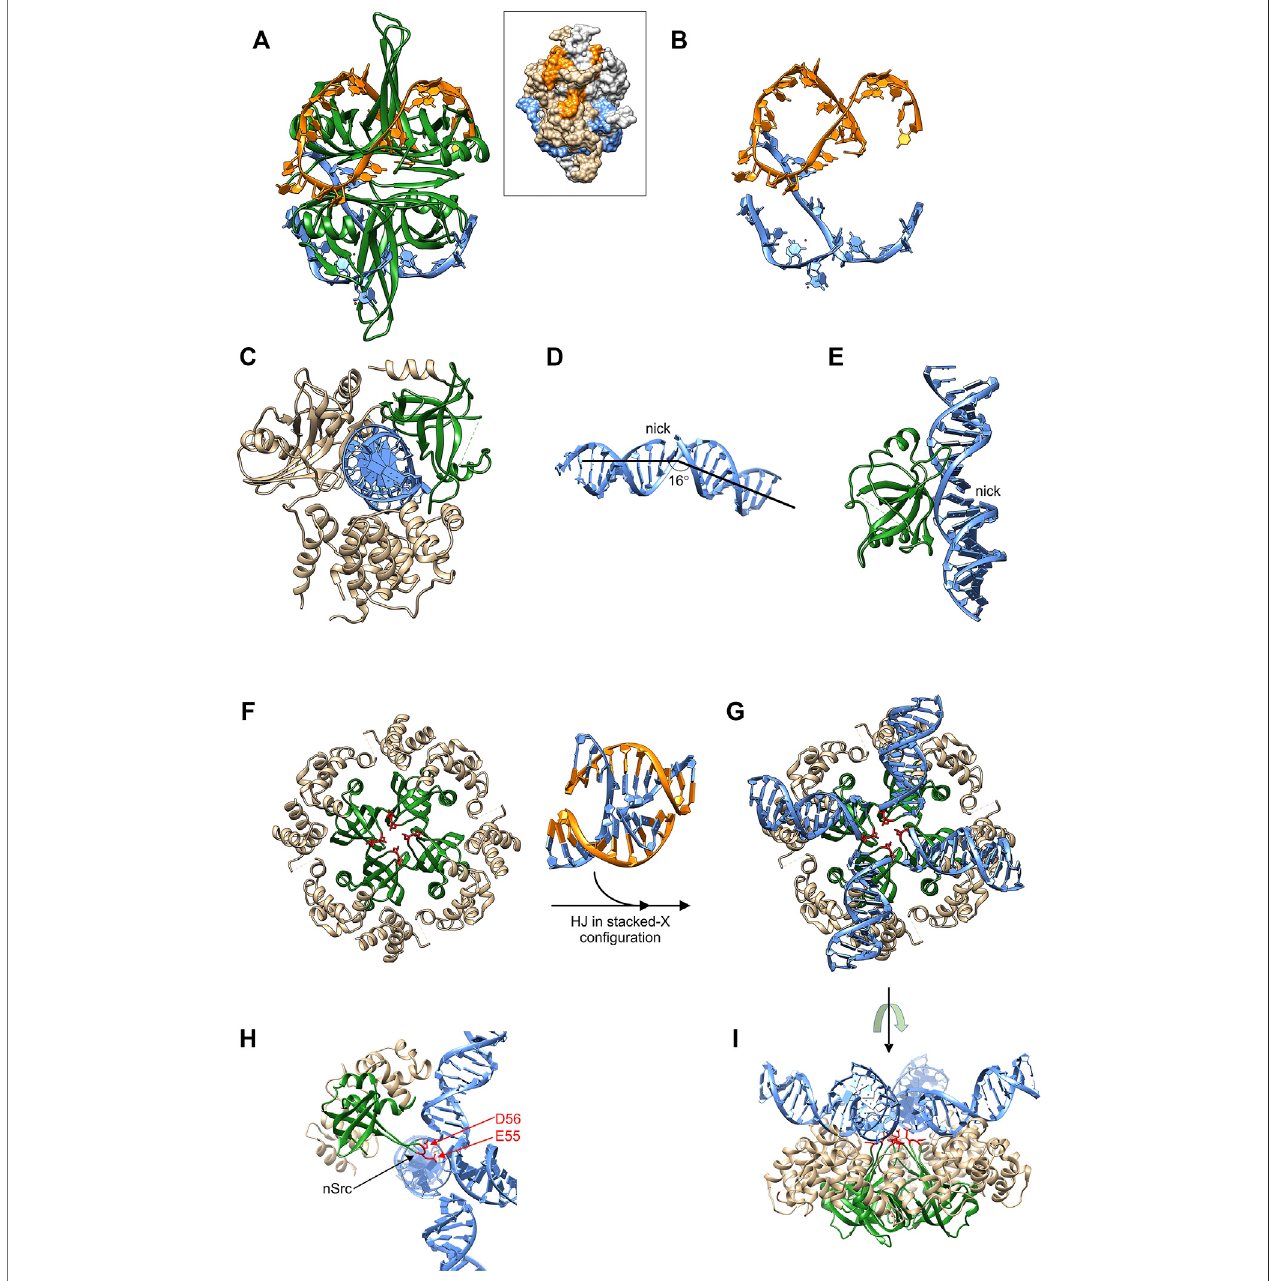
FIGURE 4 | OB-folds interact with different DNA substrates and effect different outcomes. (A) the four OB-folds of SSB form an intimate complex with ssDNA (coloured orange and light blue) which is wrapped around the tetramer (PDB fi le: 1EYG). Inset: space- fi lling image to show how ssDNA is protected. DNA strand colouringisthesameasintheribbondiagramandSSBmonomersarecolouredlightgreyandneutral. (B) thessDNAfromthecomplexin (A) . (C) DNAligaseIIIutilizesits OB-fold (coloured green) to bind to the minor groove of dsDNA (light blue) opposite a nick [PDB fi le: 3L2P; (Cotner-Gohara et al., 2010)]. (D) The bent and underwound DNA from the structure in (C) . (E) A side view of the RT-loop of the DNA ligase III OB-fold interacting with the widened minor groove of the nicked duplex. (F) – (I) , The RuvA tetramer utilizes catalytic OB-folds to facilitate branch migration. Four images of the RuvA tetramer are shown [PDB File: 1C7Y; (Ariyoshi et al., 2000)]. The apo form is shown in (F) so that the four OB-folds (coloured in green) can be seen with the acidic residues indicated in red. (G) RuvA binds to a HJ (PDB File: 1M6G (Thorpeetal.,2003)),convertingitintoaplanarXcon fi guration.TheorientationinGisthesameasin (F) . (H) OnesubunitofRuvAispresentedinasideviewwiththeOB- fold in the same position as Figure 2B . Here, the extended nSrc loop places the acidic residues into the center of the junction. (I) These residues catalyze drive strand separationasarms oftheHoliday Junctionaretranslocatedacrossthesurfaceofthetetramer. Heretranslocation isdriven byATPhydrolysisin fl ankingRuvB hexamers (not shown). (J) and (K) The OB-folds in MCM proteins are arranged around the center ofthe ring to facilitate binding to ssDNA (PDB fi le: 4POG). In panel J, the protein- DNA complex is viewed from the top so that the positions of the Zn fi ngers can be seen (beneath the transparent yellow spheres). The positions of 2, ssDNA fragments are alsovisible inthisview.In panelK,thecomplexisviewedfrom thebottom withhighly conserved argininescolouredinred withthose from4of6subunitsin proximity to the ssDNA [R124 and 186; (Froelich et al., 2014)]. For further details of translocation in the CMG complex see (Meagher et al., 2019).